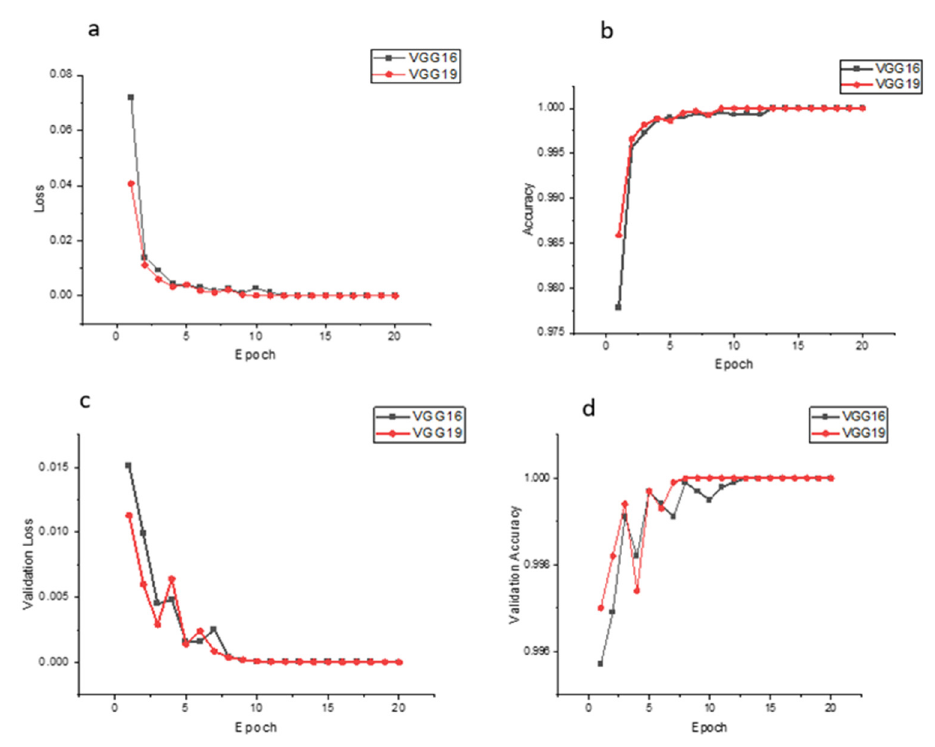
Figure 12. ( a ) Training loss of VGG16 and VGG19 ( b ) Training accuracy of VGG16 and VGG19 ( c ) Validation loss of VGG16 and VGG19 ( d ) Validation accuracy of VGG16 and VGG19.